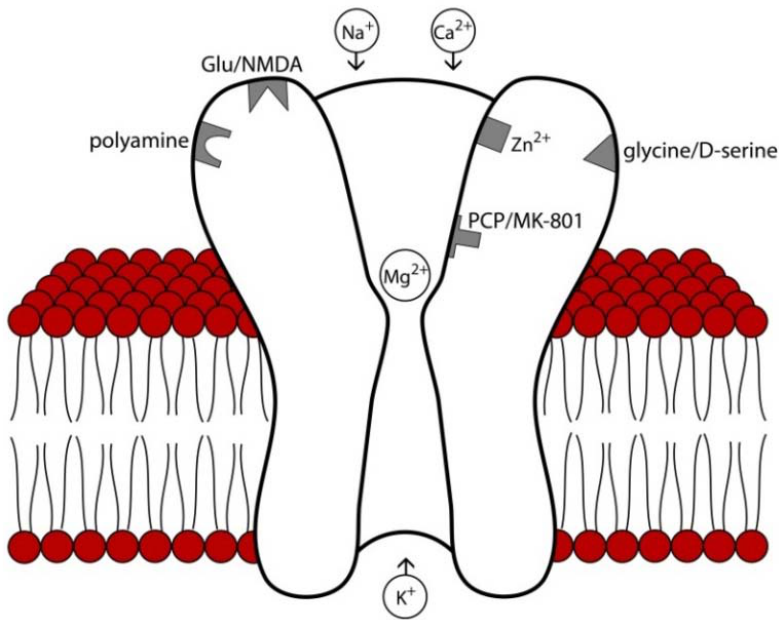
Figure 2. Structure and major binding sites of the NMDA receptor. At rest, the receptor pore is blocked by Mg 2+ which must be removed by slight membrane to allow cation conductance. Binding sites for glutamate, the endogenous co-agonists D -serine and glycine, and endogenous modulators such as polyamines, Zn 2+ , and protons are primarily localized to extracellular domains. Psychomimetic NMDA antagonists such as phencyclidine (PCP) and MK-801 bind to deep regions of the channel pore. Relevant to the pharmacological agents reviewed here, memantine blocks superficial regions of the channel pore [31], acamprosate is believed to interact with the polyamine binding site [32], and